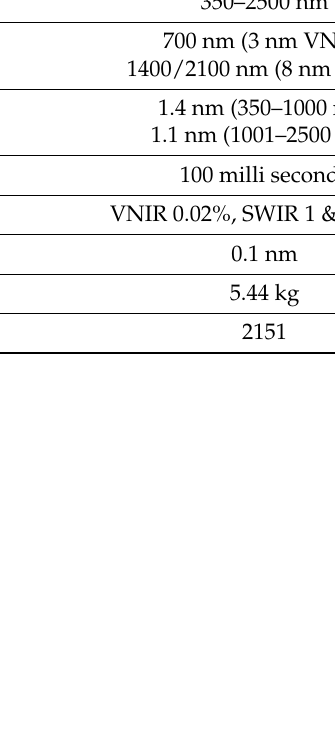
Figure 8. Calibration of ASD FieldSpec4 spectrometer.